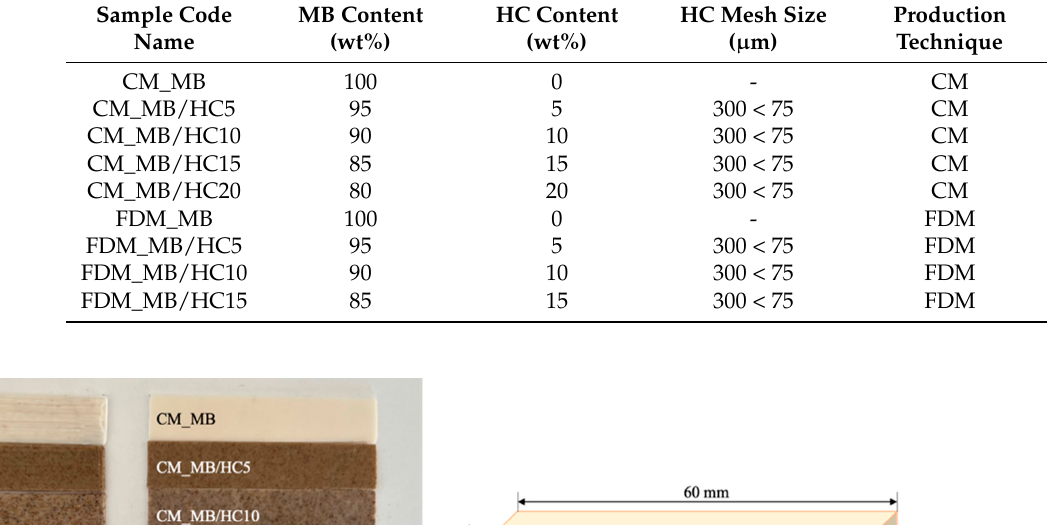
Table 2. Formulation of investigated samples.